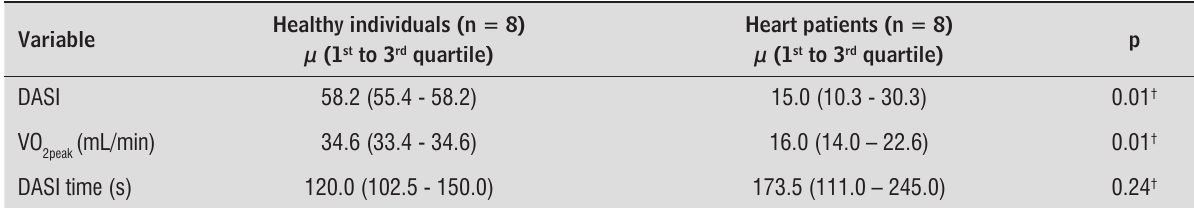
estimated by DASI and time required to fill out questionnaire among 2peak